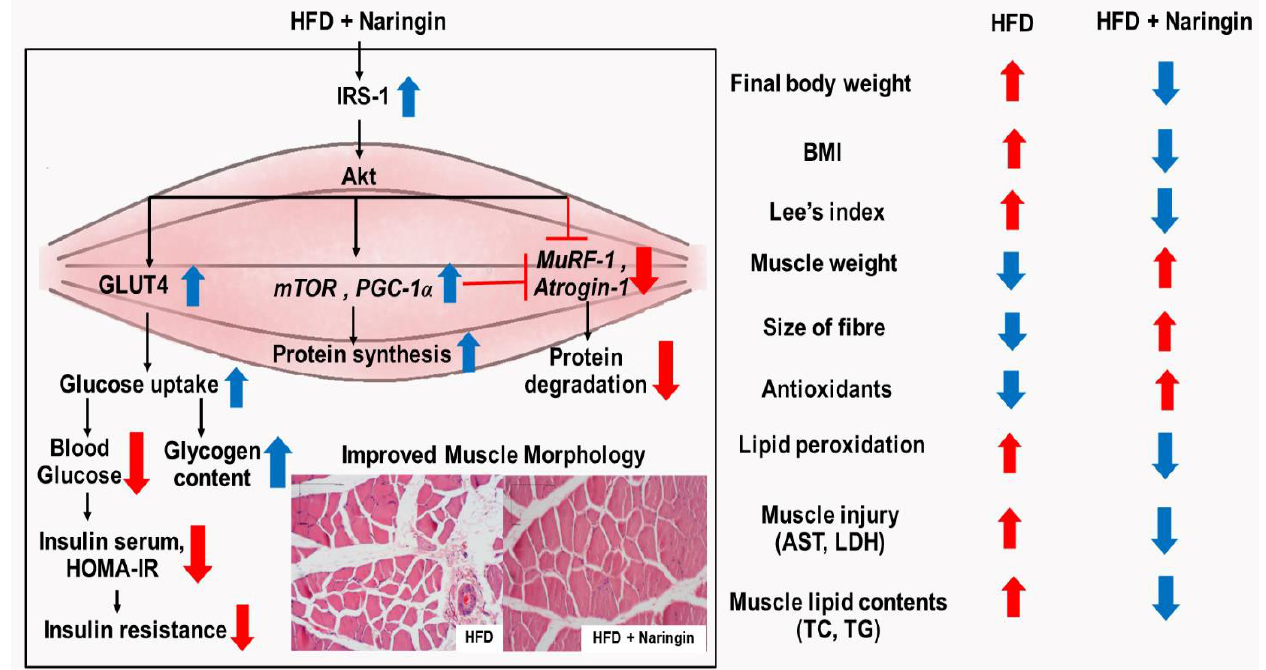
Figure 6. Schematic diagram of the possible underlying mechanism of naringin to regulate protein turnover in high-fat diet-induced obese rats. Naringin reduced the levels of muscle lipid accumulation, which causes oxidative stress, by increasing antioxidant enzymes and not only decreasing the malondialdehyde (MDA) production of lipid peroxidation but also the lactate dehydrogenase (LDH) and aspartate aminotransferase (AST), which are the indicators of muscle injury. Naringin increased the mRNA expressions of mTOR and PGC-1 α and also the protein expressions of IRS-1 and GLUT4. In addition, it increased levels of glucose uptake and glycogen content while inhibiting the mRNA expression of Atrogin-1 and MuRF-1 . This leads to increased muscle mass and size of the fibres, improvement in insulin sensitivity, and a decline in insulin resistance of skeletal muscles in high-fat-diet- induced obese rats.